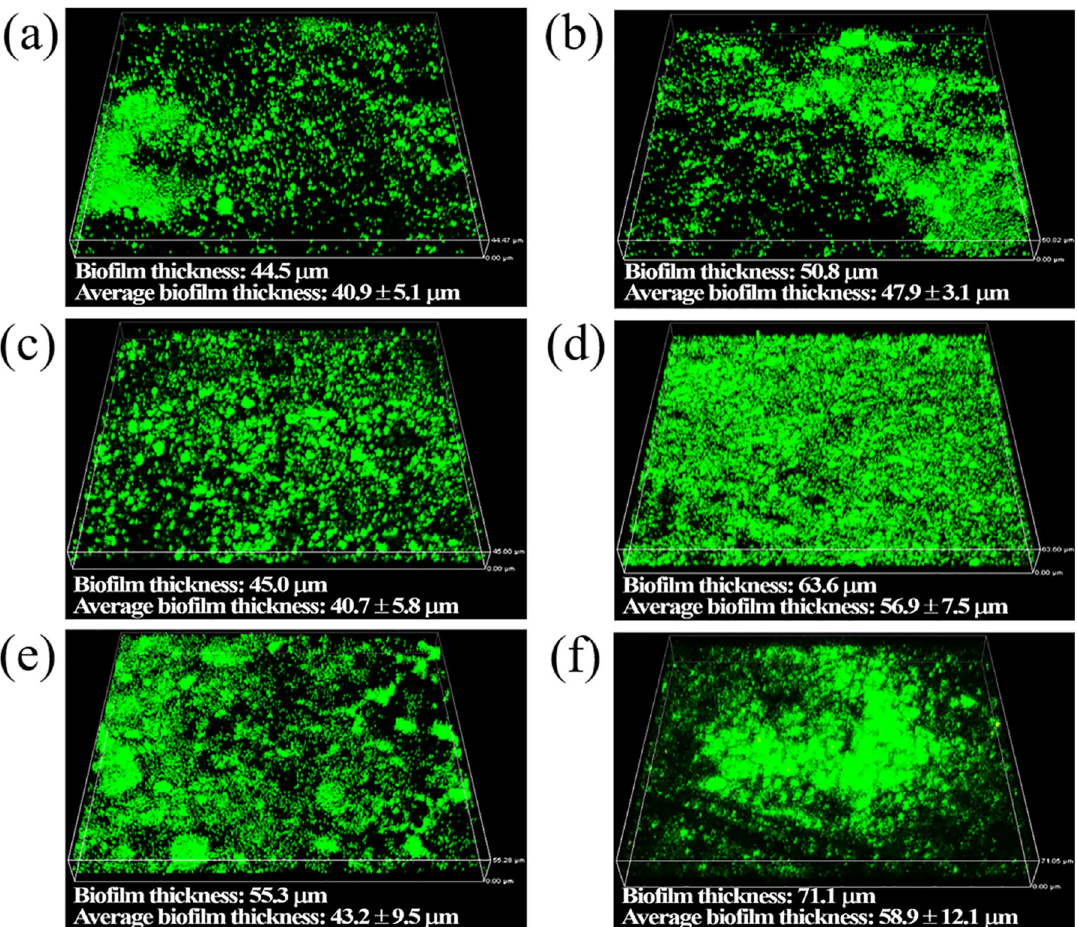
Fig. 2 3D CLSM images of bio fi lms on X80 coupons. a , b Bio fi lms of V. parahaemolyticus after 7 d and 14 d. c , d Bio fi lms of V. alginolyticus after 7 d and 14 d. e , f Bio fi lms of Vibrio sp. EF187016 after 7 d and 14